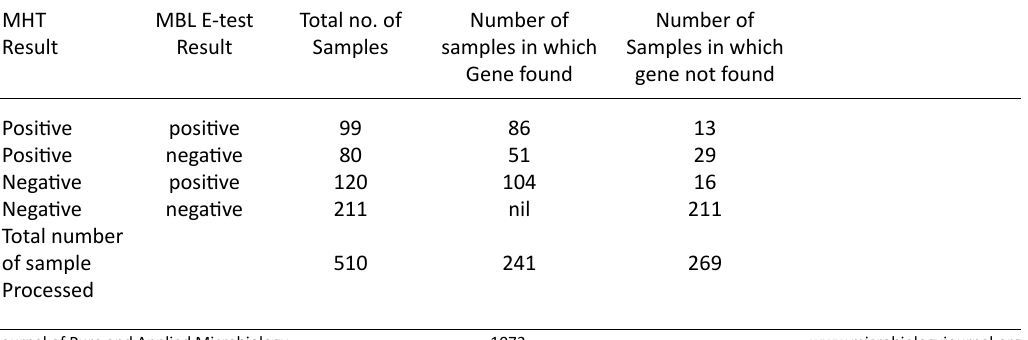
Table 4. Cross tabulation of results of phenotypic tests with gene detection MHT MBL E-test Total no. of Number of Number of Result Result Samples samples in which